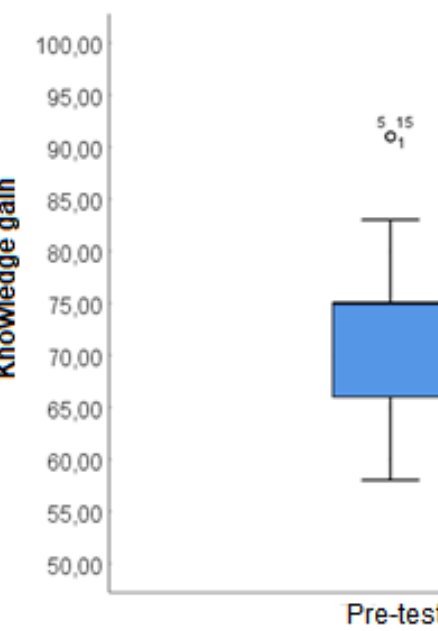
Figure 3. Knowledge gain before and after